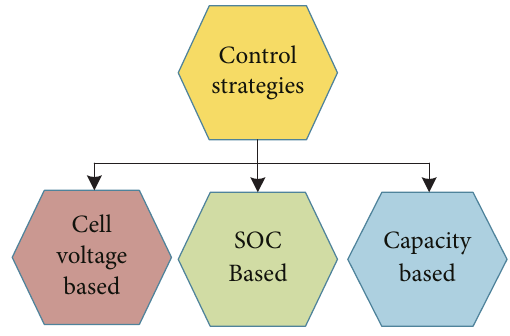
Figure 13: Classifcation of control strategies.